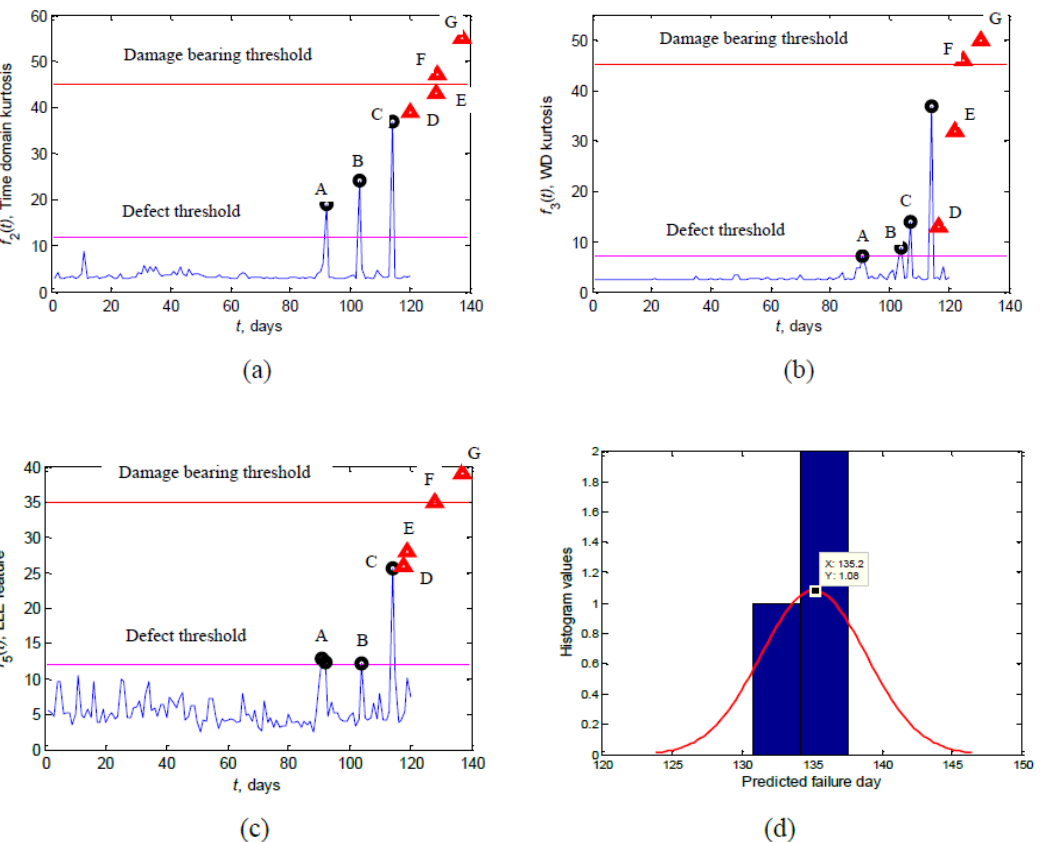
Figure 11. Prediction of modified Kernel regression: ( a ) Time-domain kurtosis; ( b ) Wavelet kurtosis; ( c ) LLE feature; ( d ) PDF of the predicted failure day of the slew bearing. 135.2 is the peak value of the normal distribution. Table 8. The prediction of failure day.